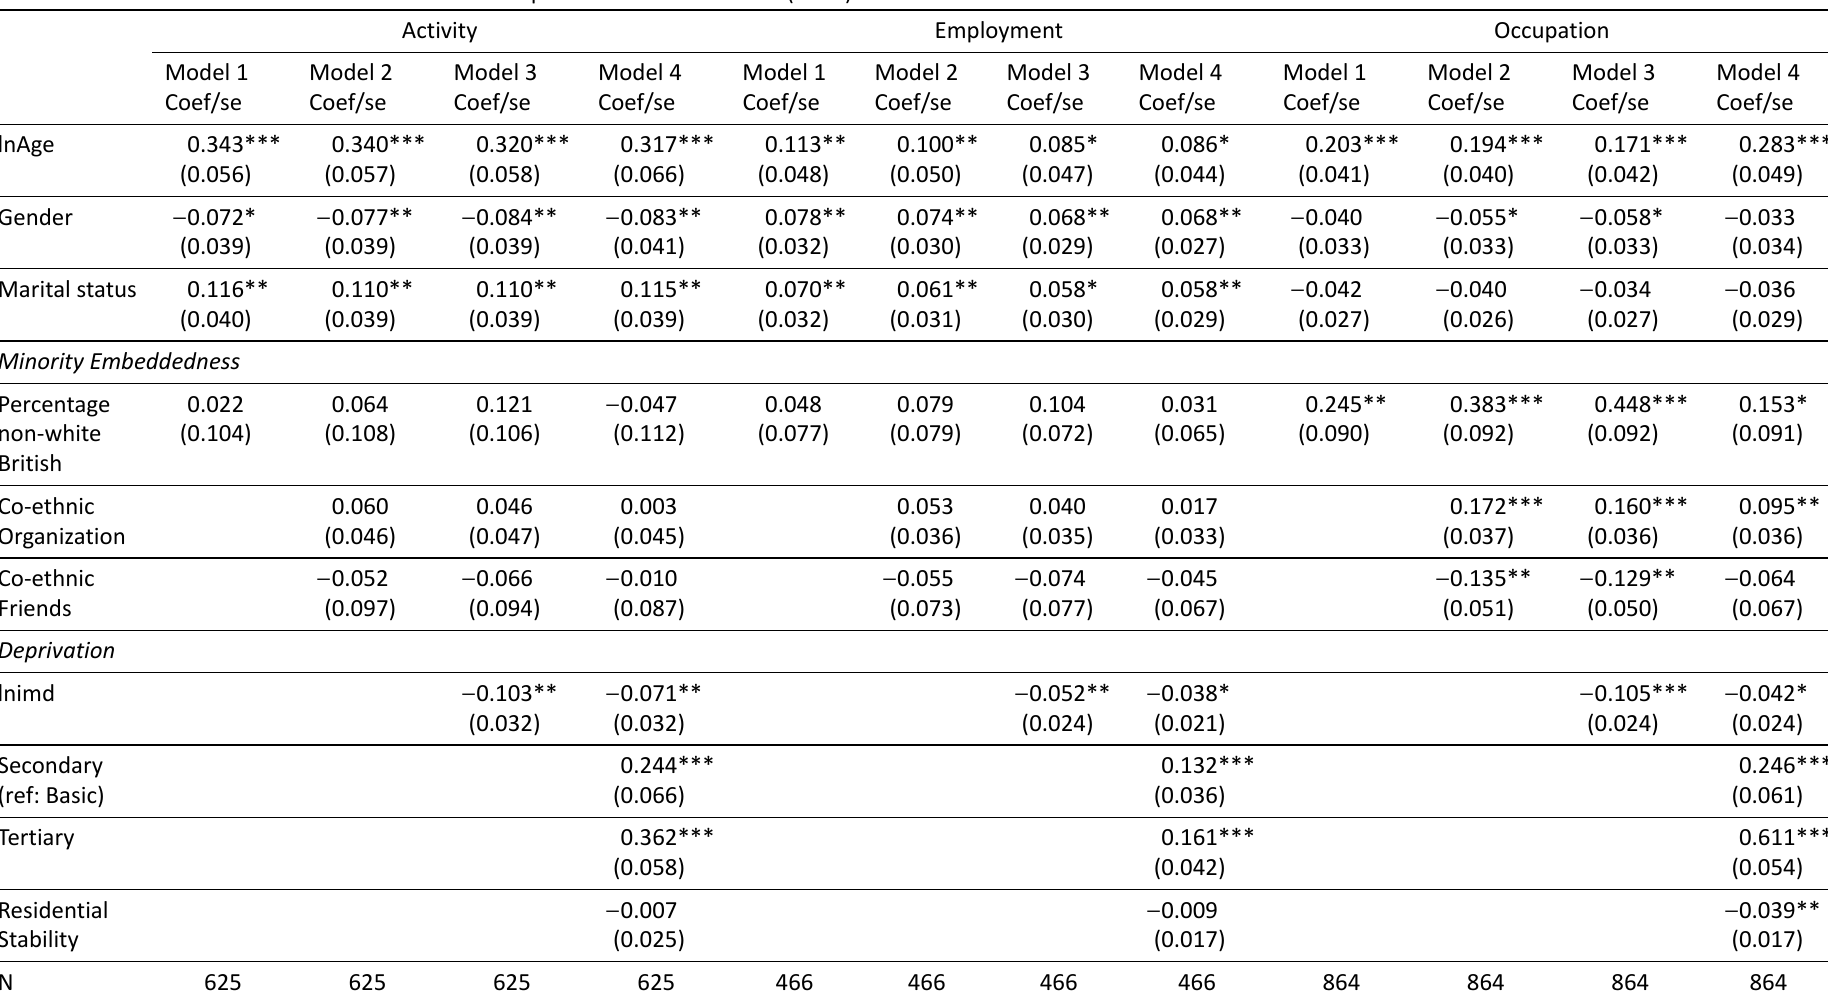
Table 3. Labour market outcomes of white British respondents. Source: MCDS